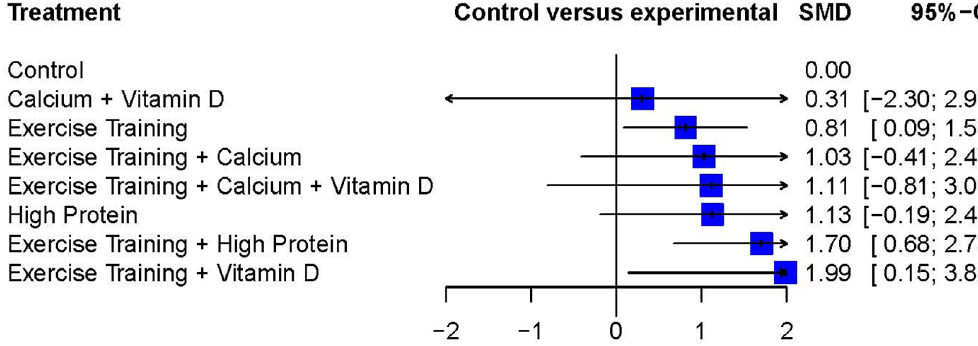
Figure 4. Network meta-analysis ranking and summary of weighted effect sizes.